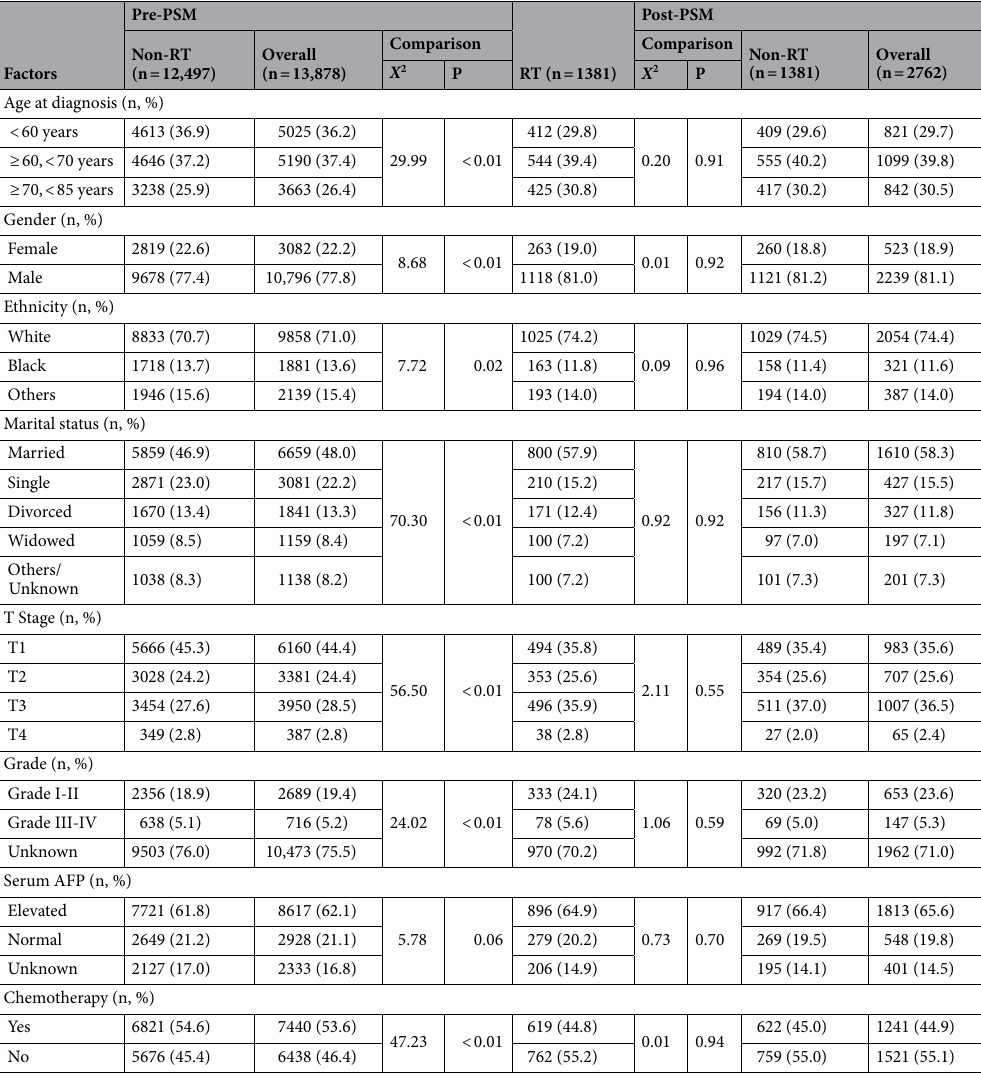
Table 1. Baseline patient characteristics before and after propensity score matching (PSM). RT radiotherapy, PSM propensity score matching, AFP